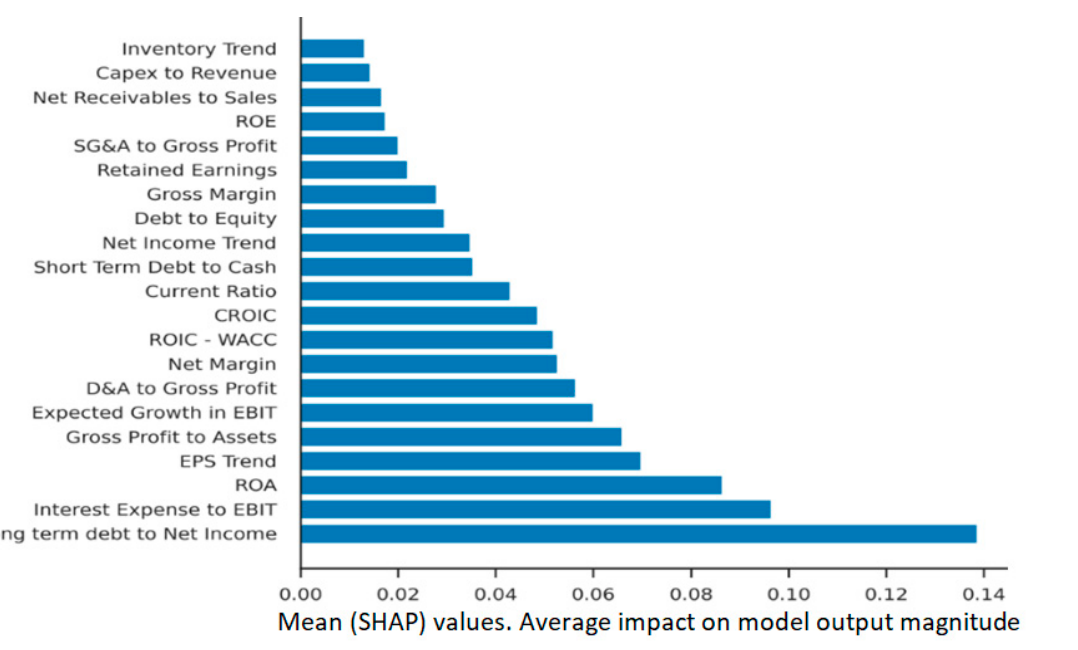
Figure 6. General feature importance. SHAP feature importance measured as the mean absolute Shapley values. Long term debt-to-net income was the most important feature, changing the predicted absolute moat probability on average by 14 percentage points (0.14 on x -axis).